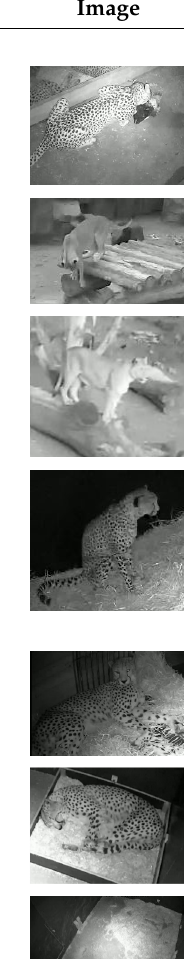
Table 1. Ethogram of captive Felidae. The classification of behaviours into resting and activity was done according to Regaiolli et al. [72].